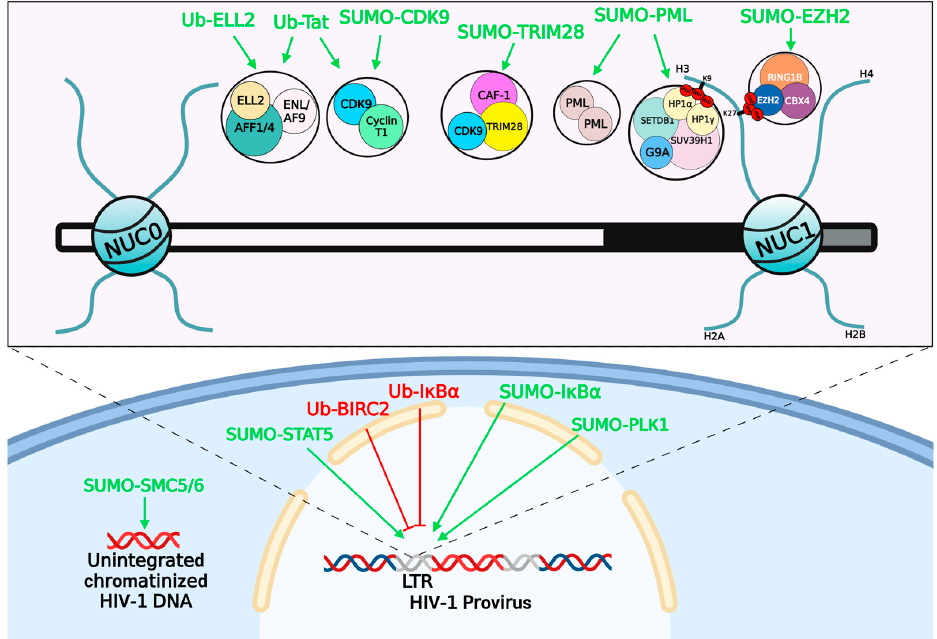
Figure 4. Schematic of HIV-1 latency and corresponding latency contributors and suppressors. The amplified region represents HIV-1 LTR where harbors the HIV-1 promoter. Protein complexes, which influence HIV-1 latency, are shown above the LTR. Proteins and arrows marked “red” represent inhibiting HIV-1 latency. Proteins and arrows marked “green” represent promoting HIV-1 latency. The exact functions of each protein can be found within the main text and Table 2.